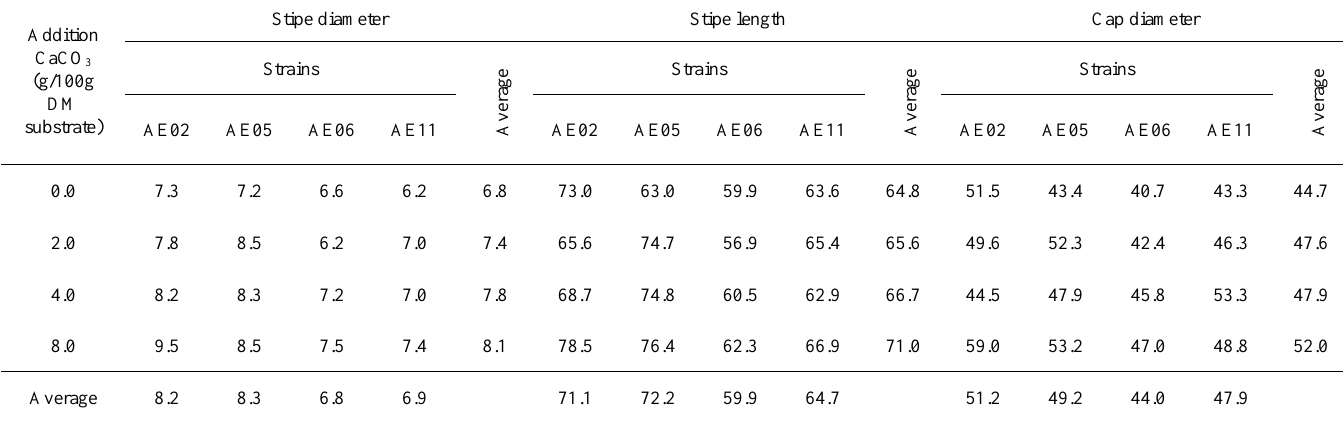
Table 2. Influence of addition of CaCO 3 on morphological features – stipe length and diameter, cap diameter [mm]